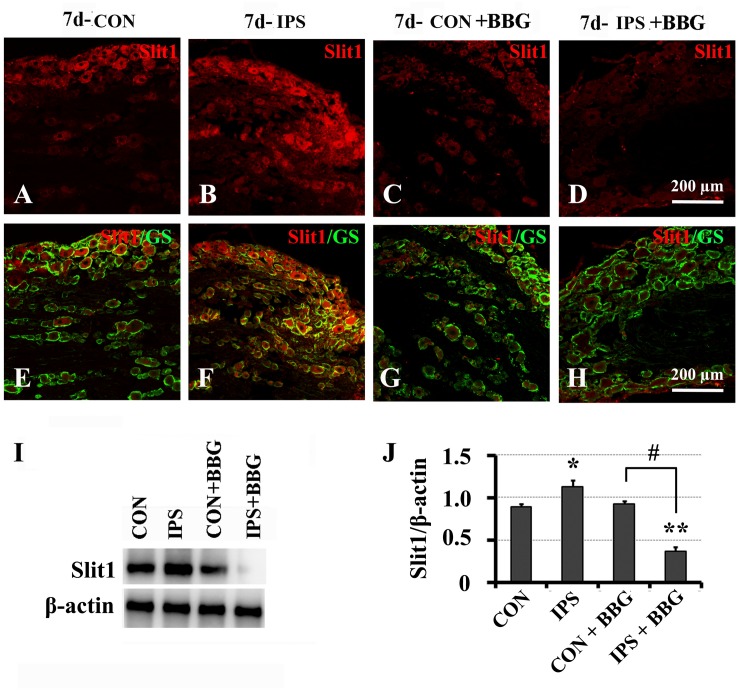
Slit1 expression in SGCs decreased after inhibition of the P2X7 receptor with BBG. After right sciatic nerve crush, BBG (P2X7 receptor inhibitor) was injected intraperitoneally. The expression of Slit1 on the 7th day DRG was detected by double immunofluorescence staining and western blotting. (A–D) Slit1 immunofluorescence staining (red). (E–H) Merged images of Slit1 (red) and GS (green) immunofluorescence staining. Scale bar = 200 μm. (I) the level of Slit1 protein was detected by western blotting (N = 3), the level of β-actin was detected as loading control. (J) The level of Slit1 before and after BBG treatment on the 7th day post-SNC DRG was analyzed with the paired t-test. “∗” compared with the control side, the level of Slit1 in IPS side was upregulated, P < 0.001; “#” compared with the control side and the ipsilateral side before BBG treatment respectively, the level of Slit1 in “IPS + BBG” was downregulated, P < 0.001; The change was not significant in “CON + BBG”, P > 0.05. “∗∗” compared with “CON + BBG” group, the level of Slit1 in “IPS + BBG” was much lower than that in “CON + BBG” group, P < 0.001. CON: contralateral DRG, IPS: ipsilateral DRG.